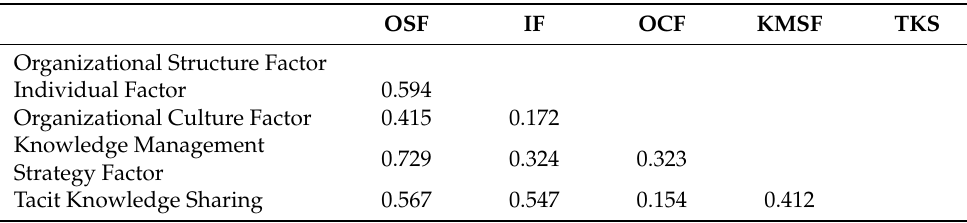
Table 4. Discriminant validity (HTMT).